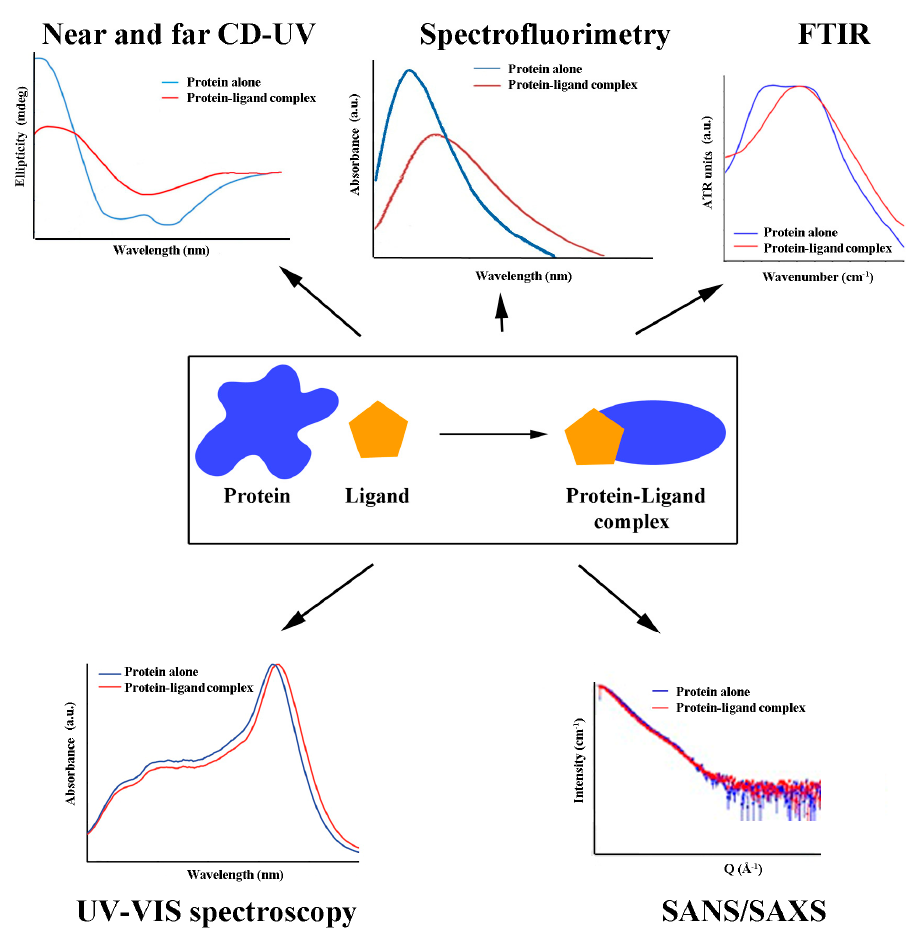
Figure 1. Structural consequences of antioxidant/protein